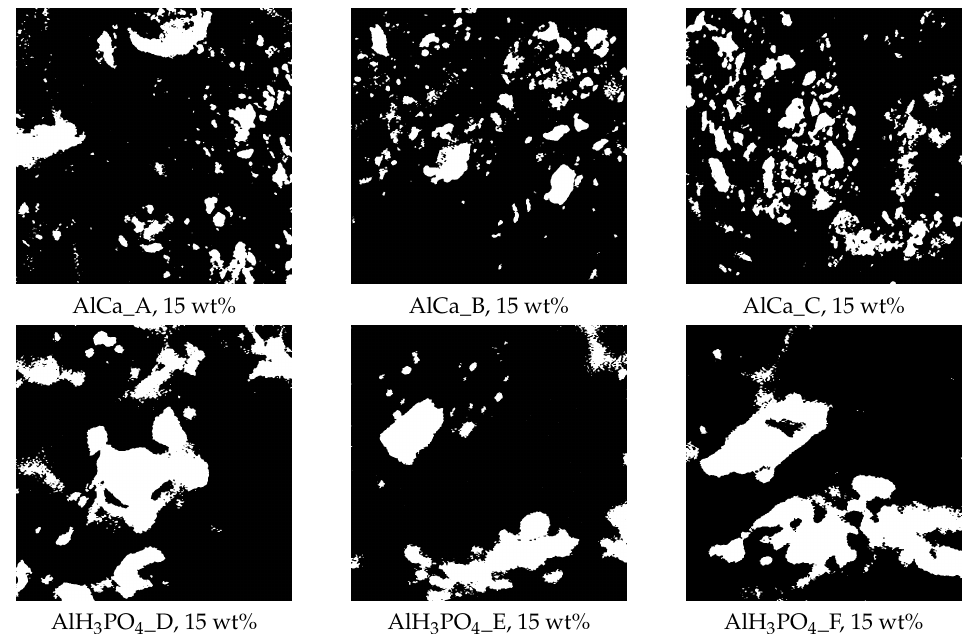
Figure 3. Exemplary images of alginate membranes, i.e., cross-linked by calcium chloride and phosphoric acid, containing 15 wt% magnetite particles, prepared for numerical simulation and analysis. Structural parameters: AlCa_A ( ρ = 0.89, d f = 1.9751, ∆ D = 0.3974B; AlCa_B ( ρ = 0.87, d f = 1.9809, ∆ D = 0.3205); AlCa_C ( ρ = 0.84, d f = 1.9711, ∆ D = 0.2310); AlH 3 PO 4 _D ( ρ = 0.79, d f = 1.9531, ∆ D = 2.0629); AlH 3 PO 4 _E ( ρ = 0.66, d f = 1.9137, ∆ D = 1.8077); and AlH 3 PO 4 _F ( ρ = 0.77, d f = 1.9462, ∆ D = 1.2272).